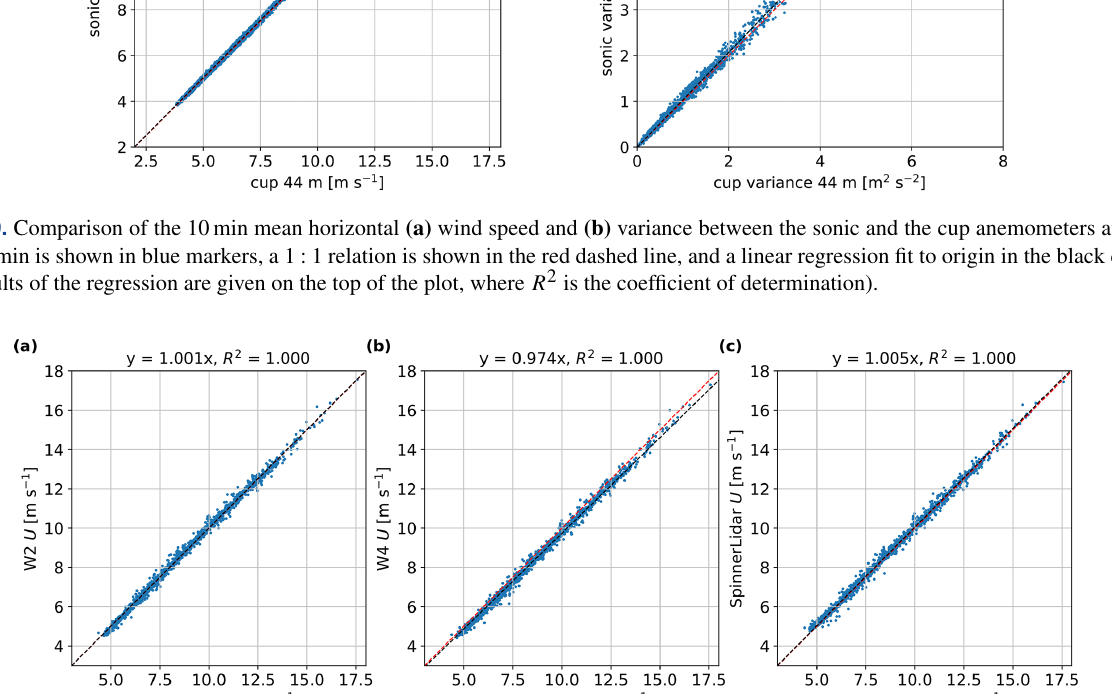
tion of (cid:104) u (cid:48) w (cid:48) (cid:105) , respectively, to the beam radial variance.